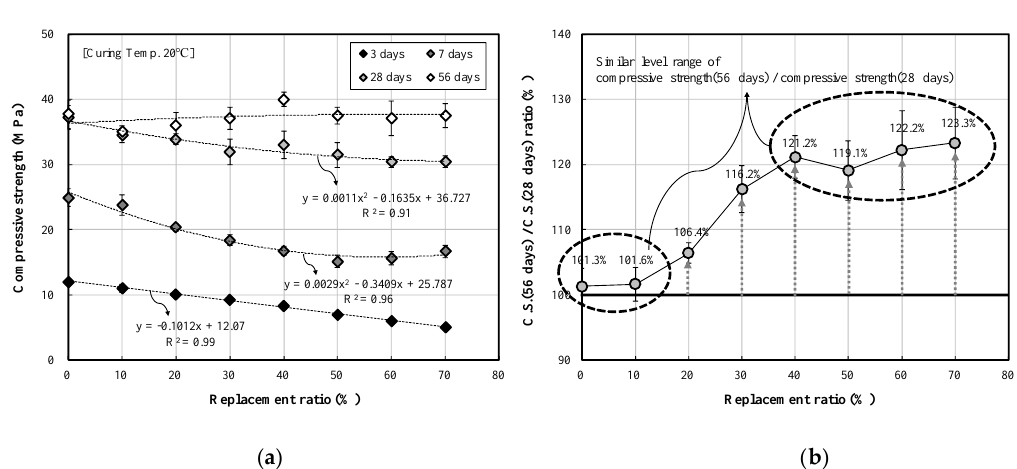
Figure 8. Results of ( a ) compressive strength and ( b ) CS (56 d)/CS (28 d) ratio with respect to the replacement ratio.